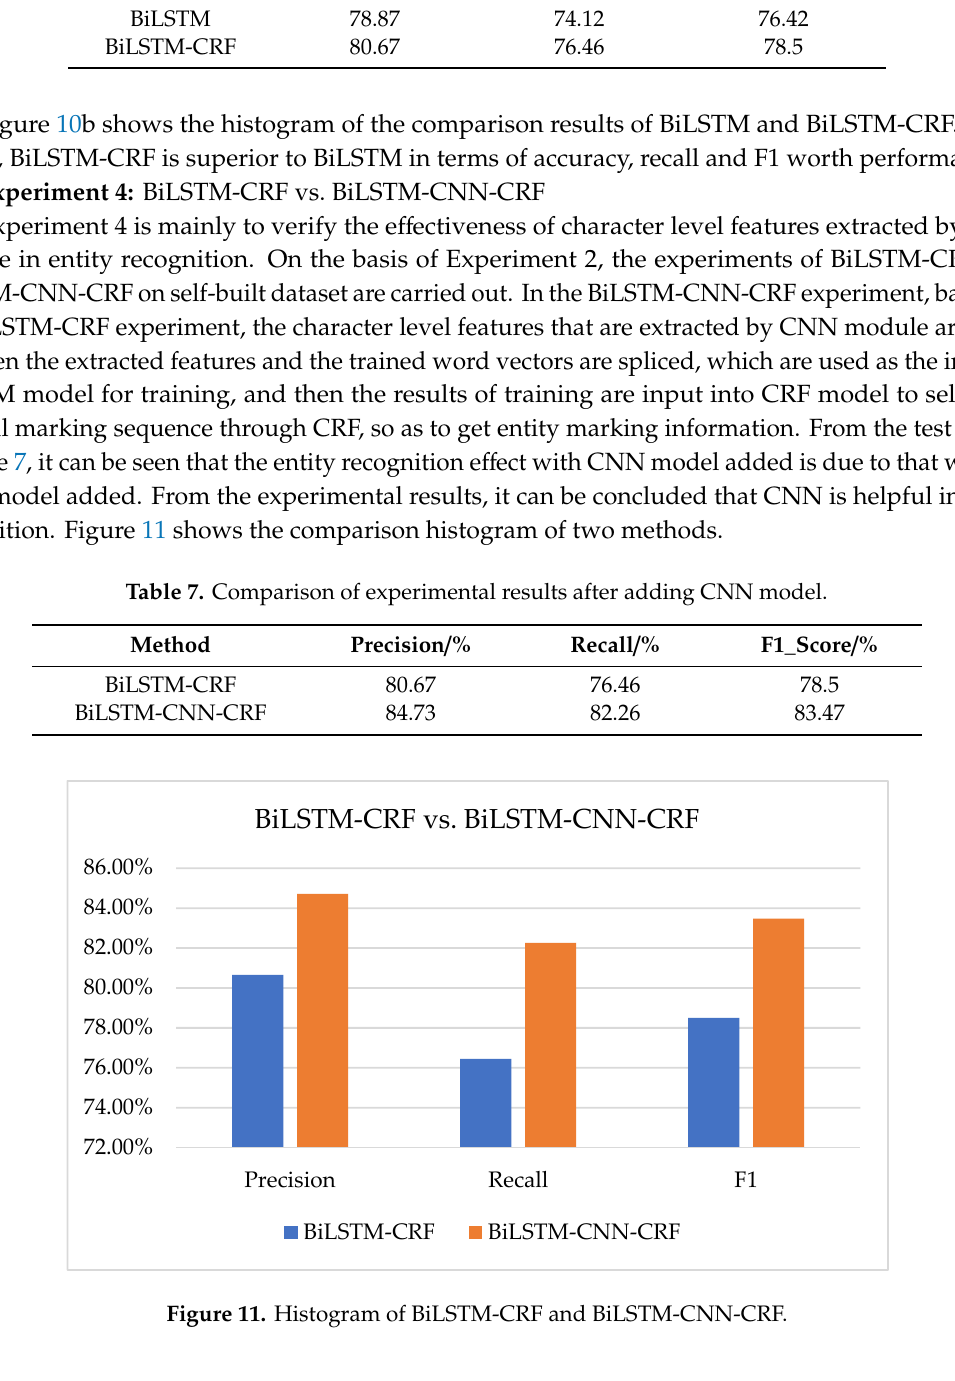
Table 6. Comparison of experimental results after adding CRF model.